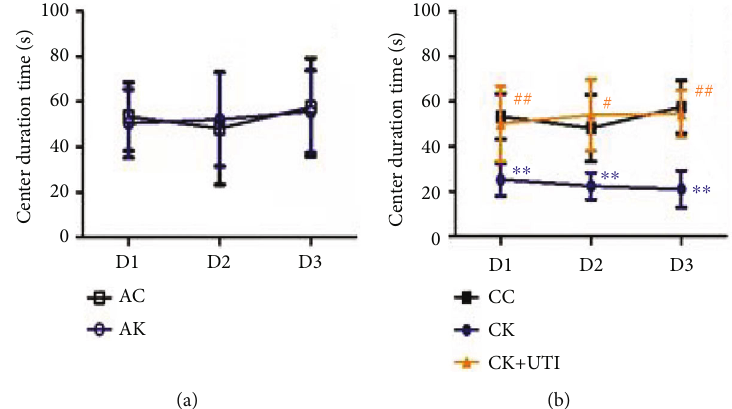
Figure 3: Repetitive KET treatment in mice evoked anxiety-like behaviors. (a) and (b) showed the center duration time. All result data were expressed as mean ± SD ( n = 12 ). # P < 0 : 05 , ∗∗ P < 0 : 01 , and ## P < 0 : 01 .